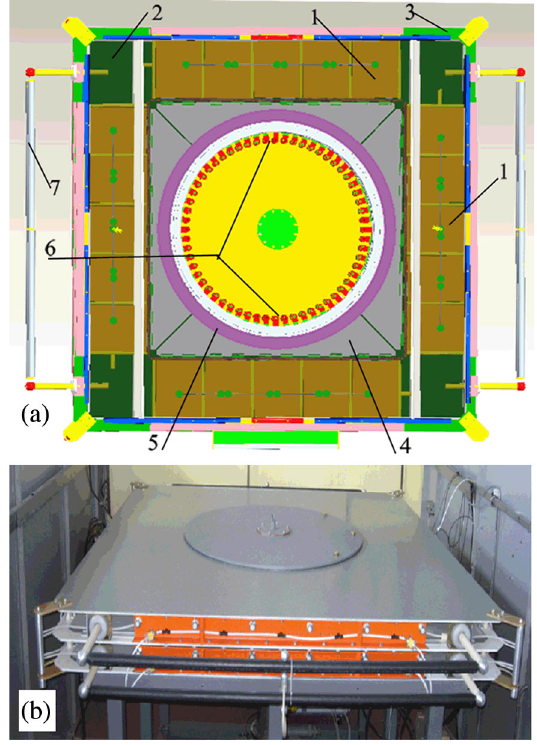
top cover (a), picture of the installation (b): 1—modules; 2— insulation; 3—stage plate; 4—combined electrode; 5—magnetic cores; 6—load resistors; 7—charging